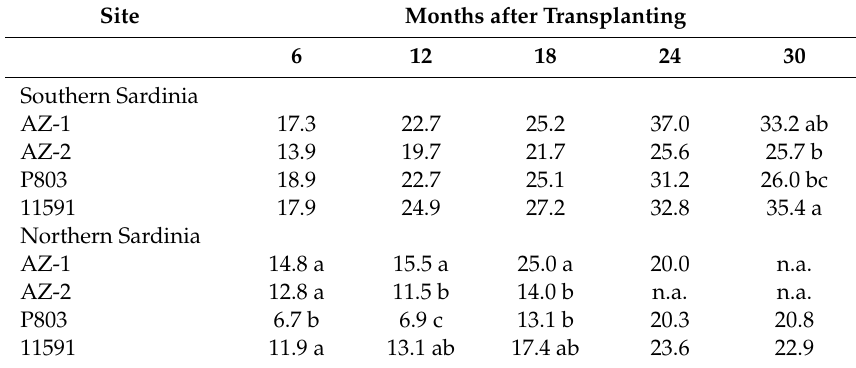
Table 4. Plant trunk diameter (mm) of guayule lines from transplanting to harvest at 30 months at the two